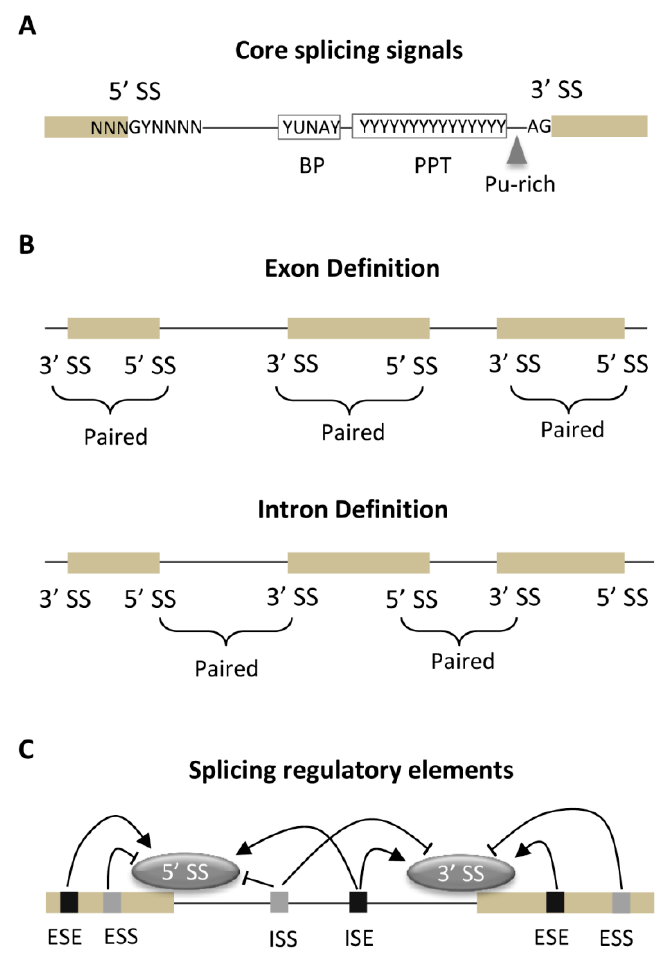
Figure 2. Splicing signals, recognition models and splicing regulatory elements. The core splicing signals within pre-mRNA and their consensus sequences are schematically illustrated ( A ). N, any purine or pyrimidine; Y, any pyrimidine; Pu-rich, purine-rich element. ( B ) The recognition models of spliceosome include “Exon Definition” and “Intron Definition”. The locations and roles of splicing regulatory elements are shown in ( C ), for which the three-letter abbreviations are stated in the main text. BP—branch point; PPT—polypyrimidine tract; ESS—exonic splicing silencers; ISS—intronic